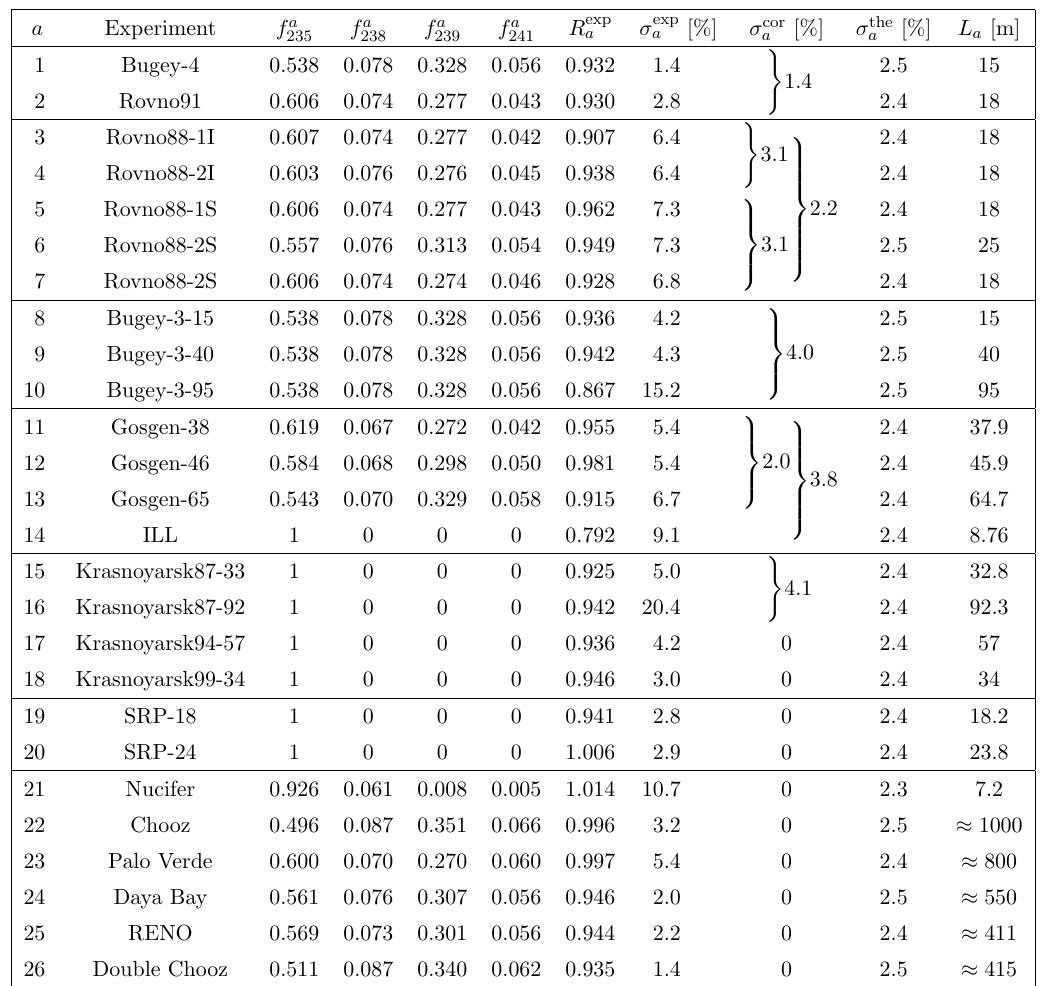
Table 1 . List of the experiments which measured the absolute reactor antineutrino (cid:13)ux. For each experiment numbered with the index a , the index k = 235 ; 238 ; 239 ; 241 indicate the four (cid:12)ssionable isotopes 235 U, 238 U, 239 Pu, and 241 Pu, f a are the (cid:12)ssion fractions, R exp is the ratio of measured a k and predicted rates, (cid:27) exp is the corresponding relative experimental uncertainty, (cid:27) cor is the relative a a systematic uncertainty which is correlated in each group of experiments indicated by the braces, (cid:27) the is the relative theoretical uncertainty which is correlated among all the experiments, and L a a is the source-detector